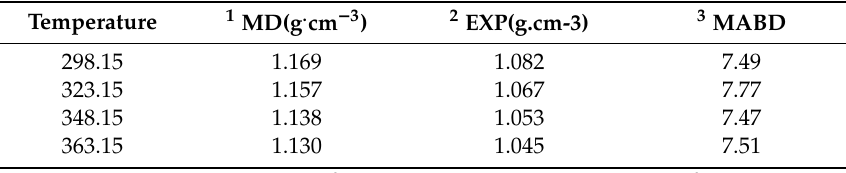
Table 3. Atmospheric liquid densities [bmim][Cl] g . cm − 3 .